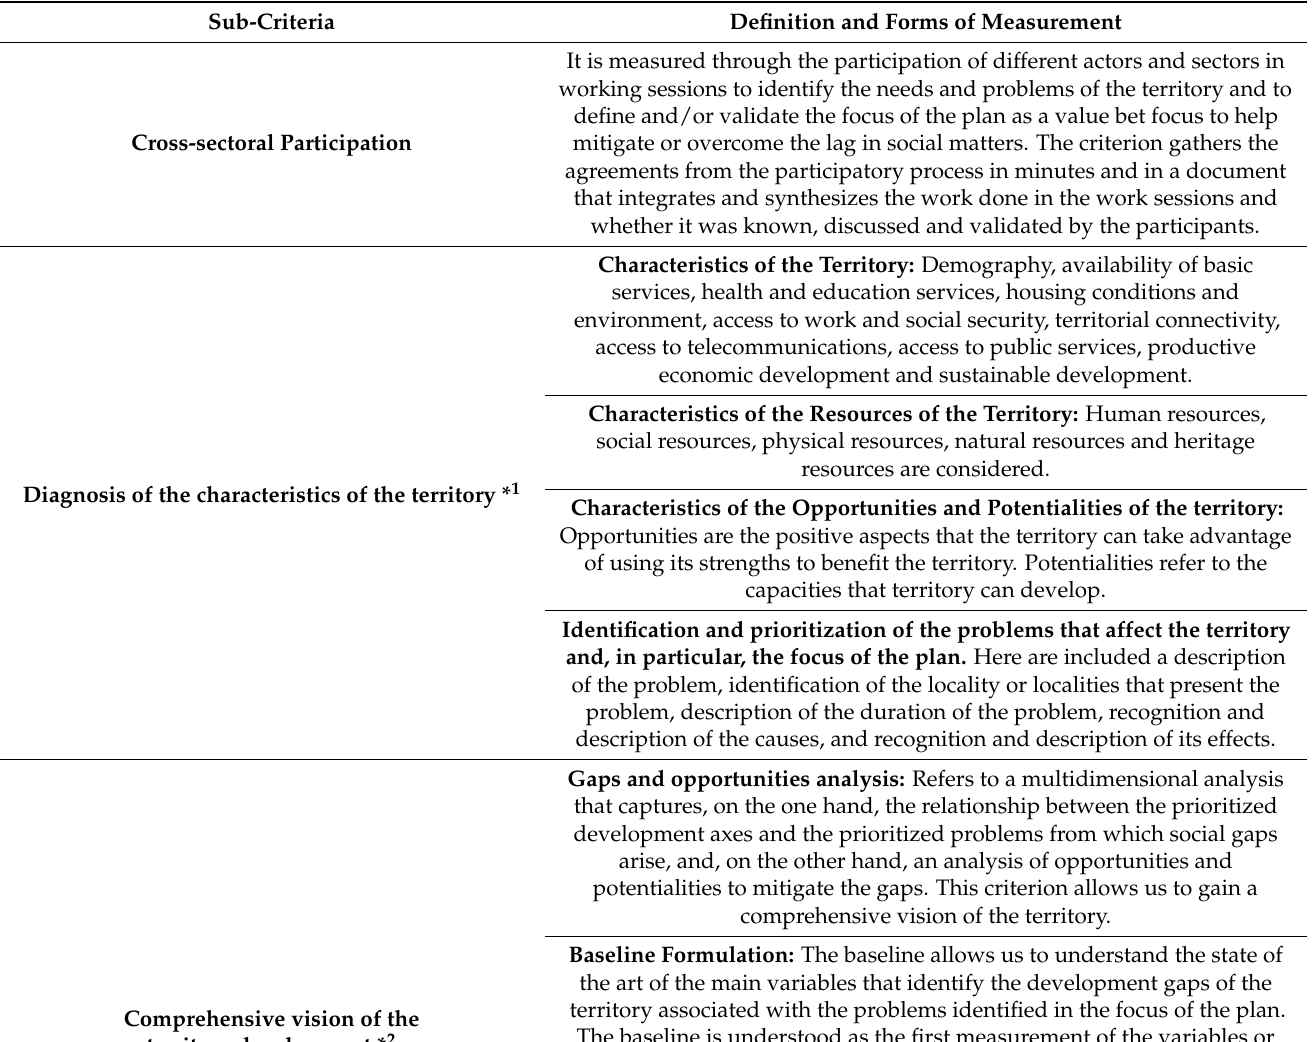
Table 1. Definitions and forms of measurement of the sub-criteria for the Criterion “Comprehensive- ness of the